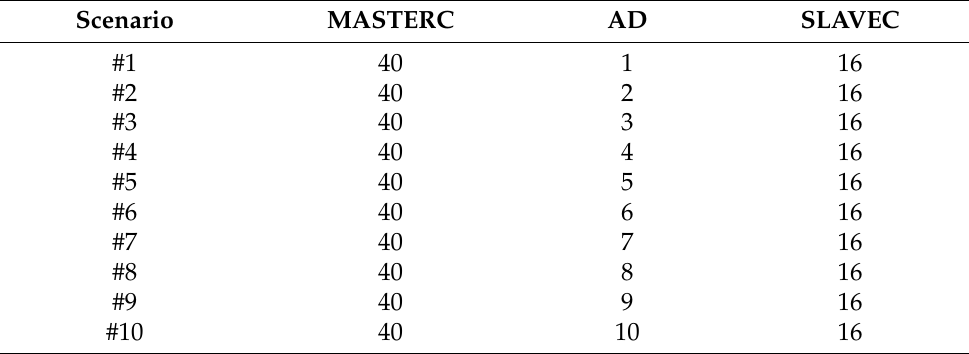
Table 4. Possible scenarios for case study 2.